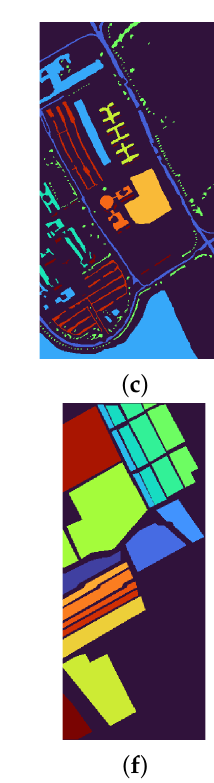
Figure 4. ( a – c ): false grayscale image, segmentation result and ground truth labels for the Pavia University dataset. ( d – f ): false grayscale image, segmentation result and ground truth labels for the Salinas HSI dataset. The former experiments achieves an Overall Accuracy of 0.93, whilst the latter achieves an OA of 0.9696.